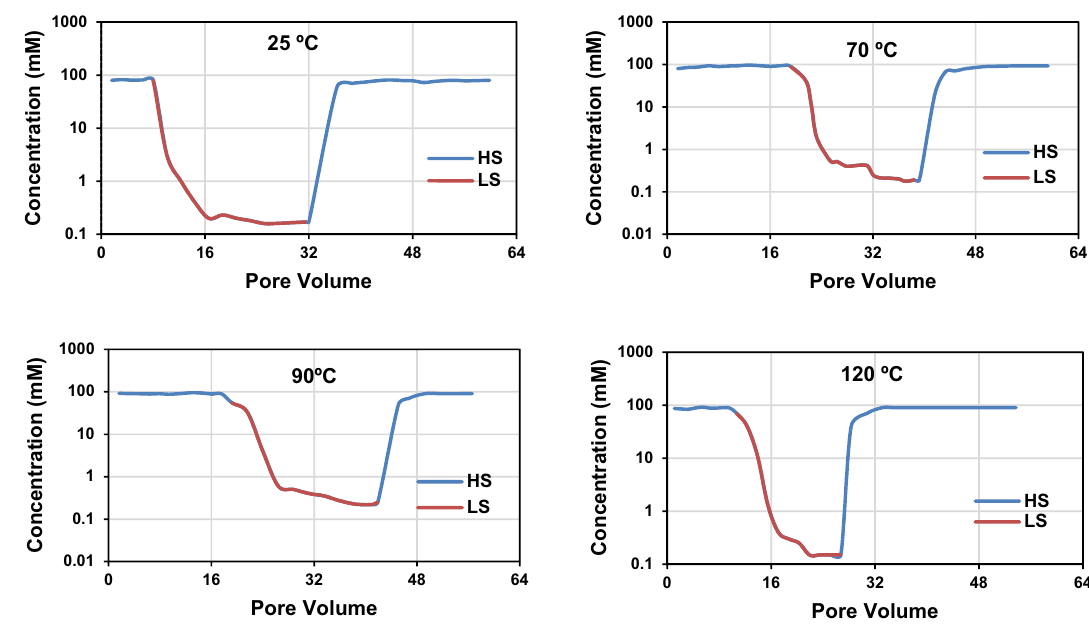
Fig. 7 Effluent concentrations of Ca 2+ from sandstone column#1 (sand + illite), at 25, 70, 90, and 120 °C